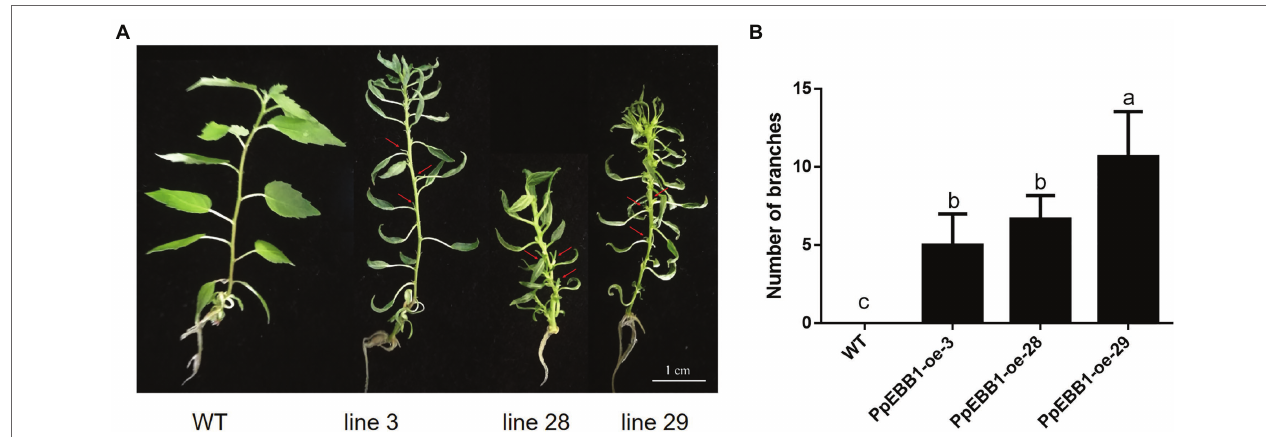
FIGURE 1 | PpEBB1-oe poplars have more branches. (A) The axillary buds in PpEBB1-oe poplar lines are outgrowth, which are pointed out with arrows, whereas axillary buds in WT remain dormant. The scale in the figure is 1 cm. (B) Branches of PpEBB1-oe poplars are grown out in subculture, and there are more branches in PpEBB1-oe poplar lines compared with WT. Shoots (>1 mm) were counted. The values represent the means ± SDs of three replicates. Letters indicate significant differences by ANOVA followed by Duncan’s test ( p <